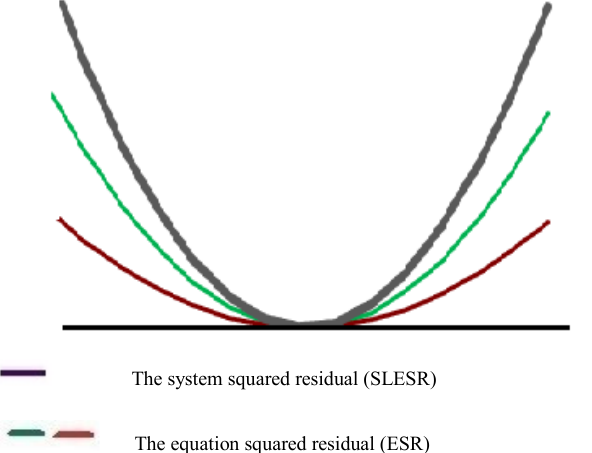
Fig. 6. SLESR and ESR on the straight line going through the SLE solution point.